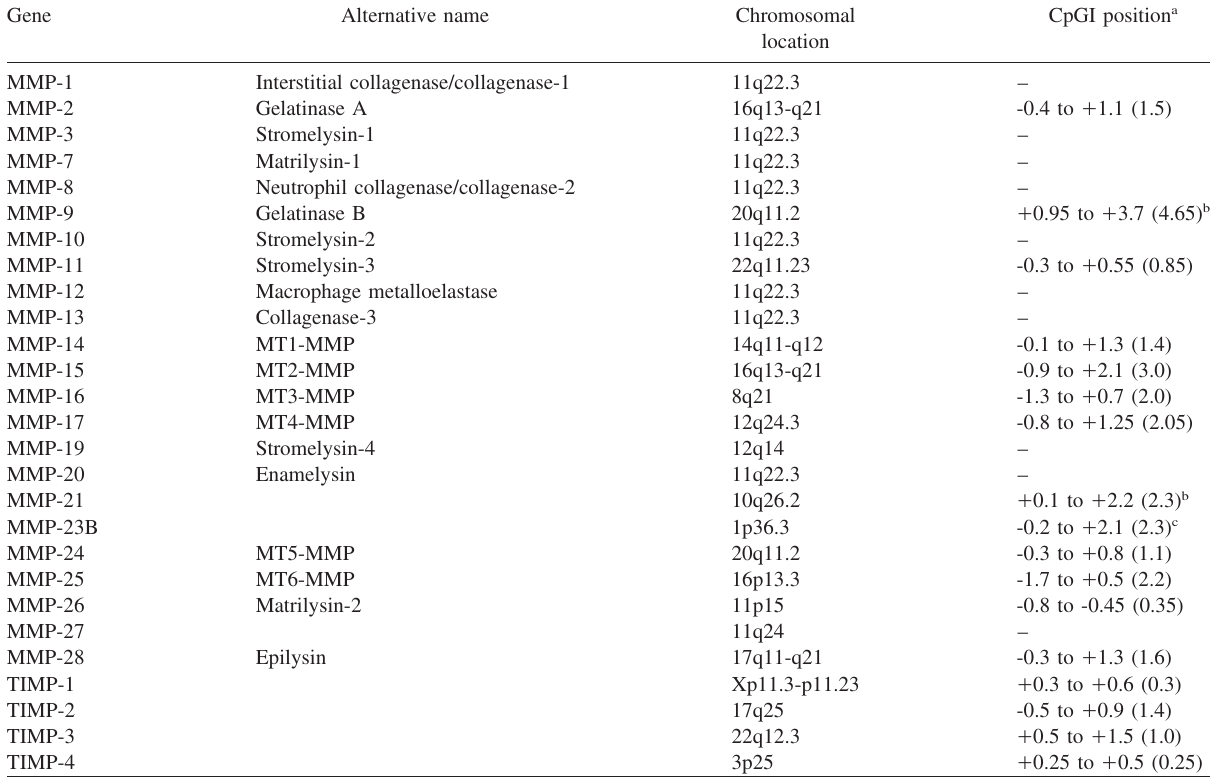
Table 1 Human MMP and TIMP